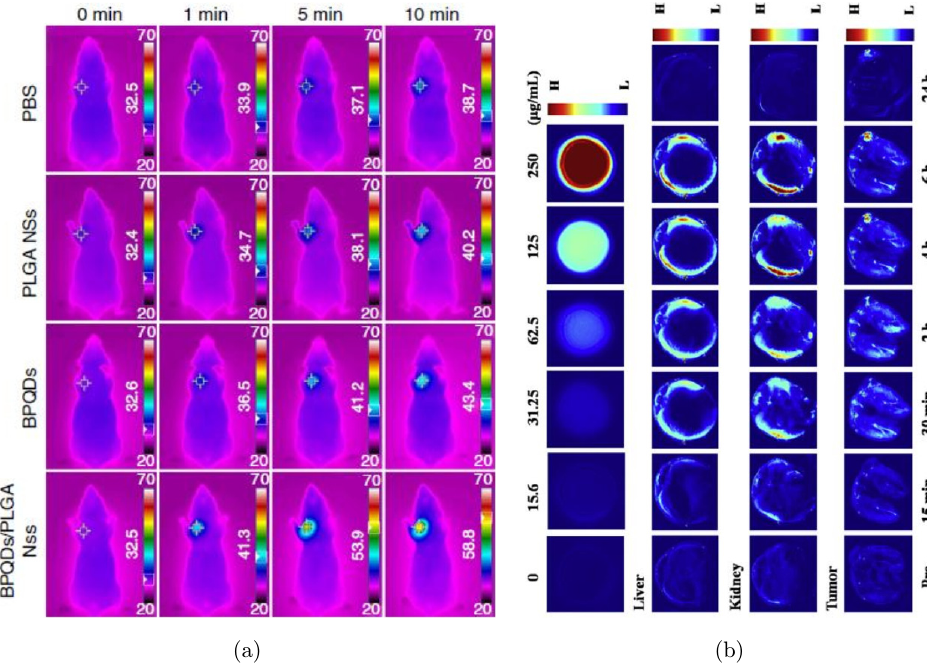
Fig. 2. (a) Infrared thermographic images in the nude mice bearing MCF7 breast tumor under NIR laser irradiation (808 nm, 1 W cm (cid:2) 2 ) after intravenous injection at 24 h with di®erent treatments. (b) PA maps of PEGylated BP nanoparticles dispersions with di®erent concentrations (¯rst column), and time-lapsed PA images of liver, kidney and tumor of female BALB/c mice after intravenous injection with PEGylated BP nanoparticles (200 mL, 2 mg mL (cid:2) 1